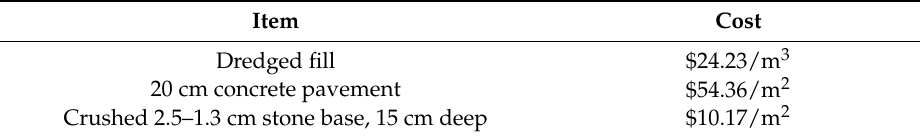
Table 2. Unit cost of ramp materials, including fill, concrete pavement, and crushed stone (2012 US dollars).